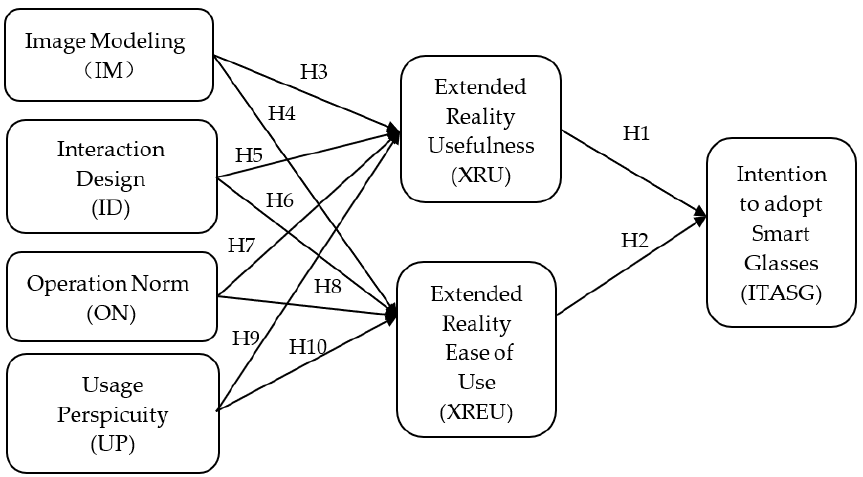
Figure 2. Proposed Conceptual